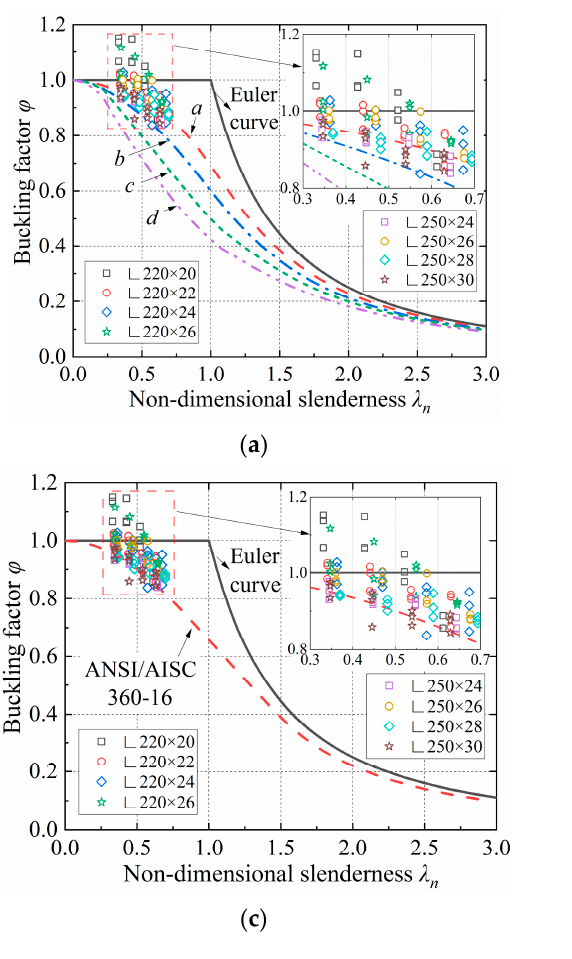
Figure 8. Comparison between test results and design curves: ( a ) GB50017-2017; ( b ) Eurocode 3; ( c ) ASCE 10-15; ( d ) ANSI/AISC 360-10.